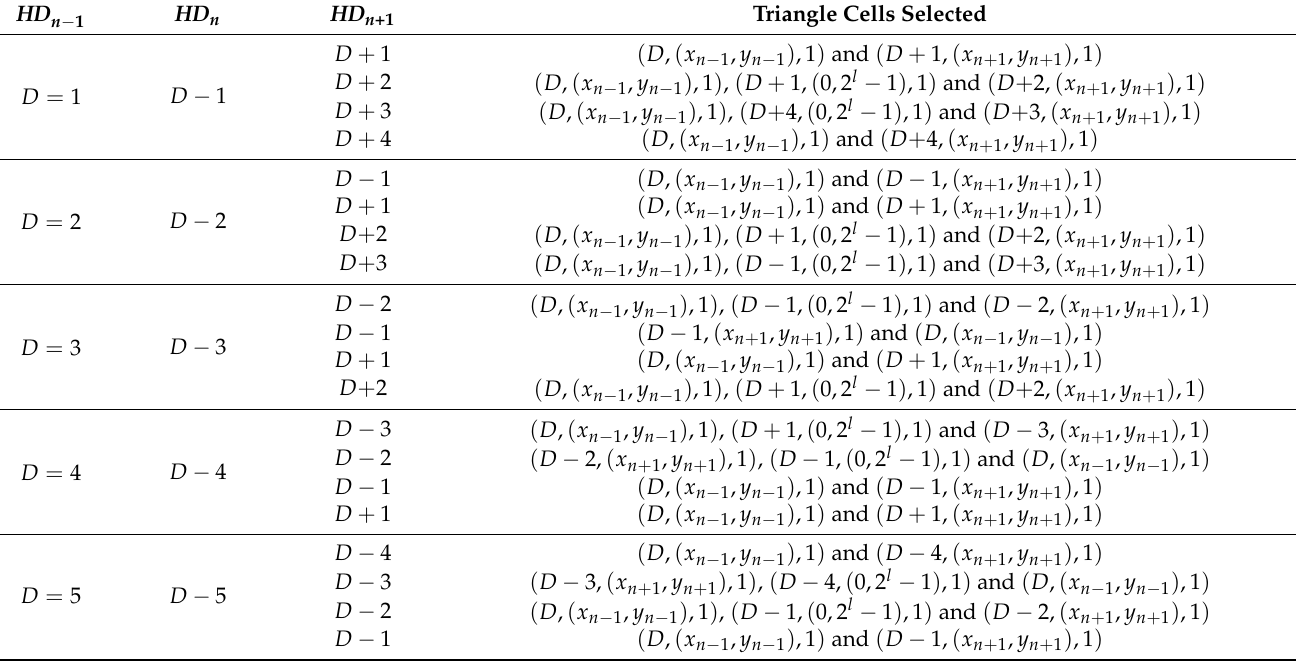
Table 12. Htotcode rule of the ( n − 1)th hexagon cell C 3 and the n th hexagon cell E 1